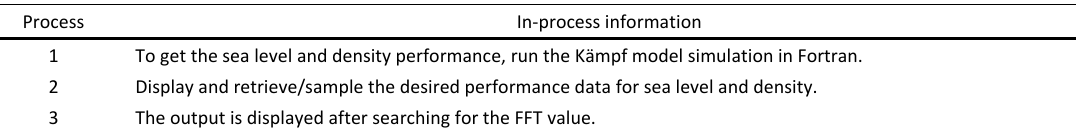
Table 1: The procedure for achieving outcomes